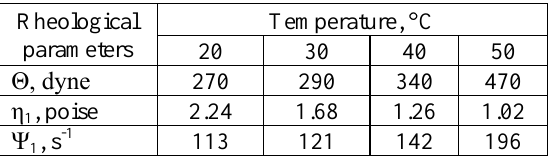
Table 1. Effect of temperature on